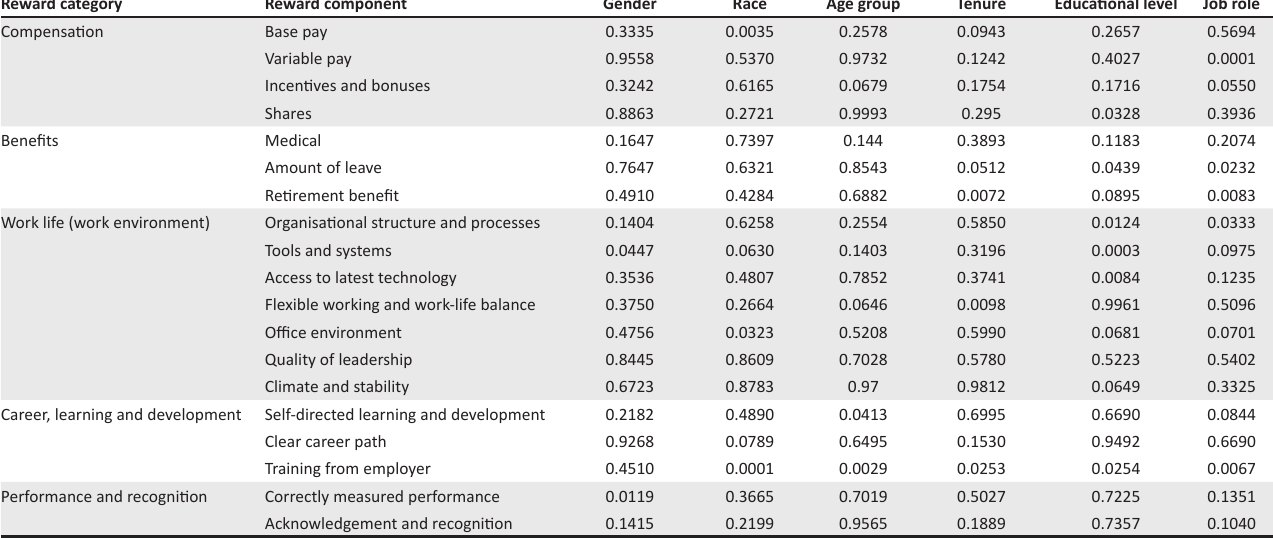
TABLE 4: Summary of reward preference comparisons by demographics. Reward category